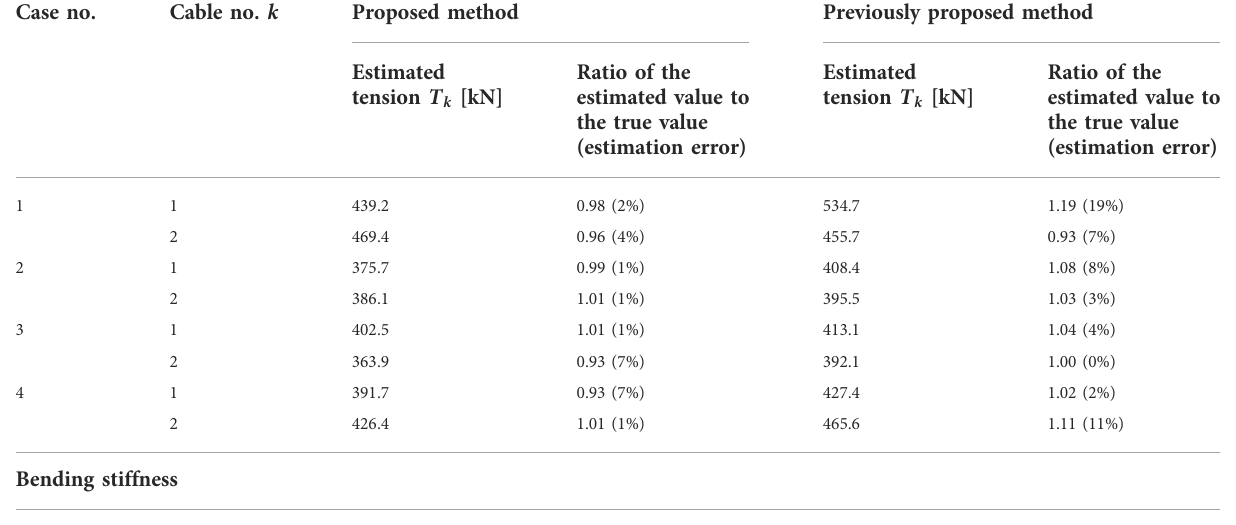
TABLE 6 Estimation results obtained by fi eld experiment. Tension Case